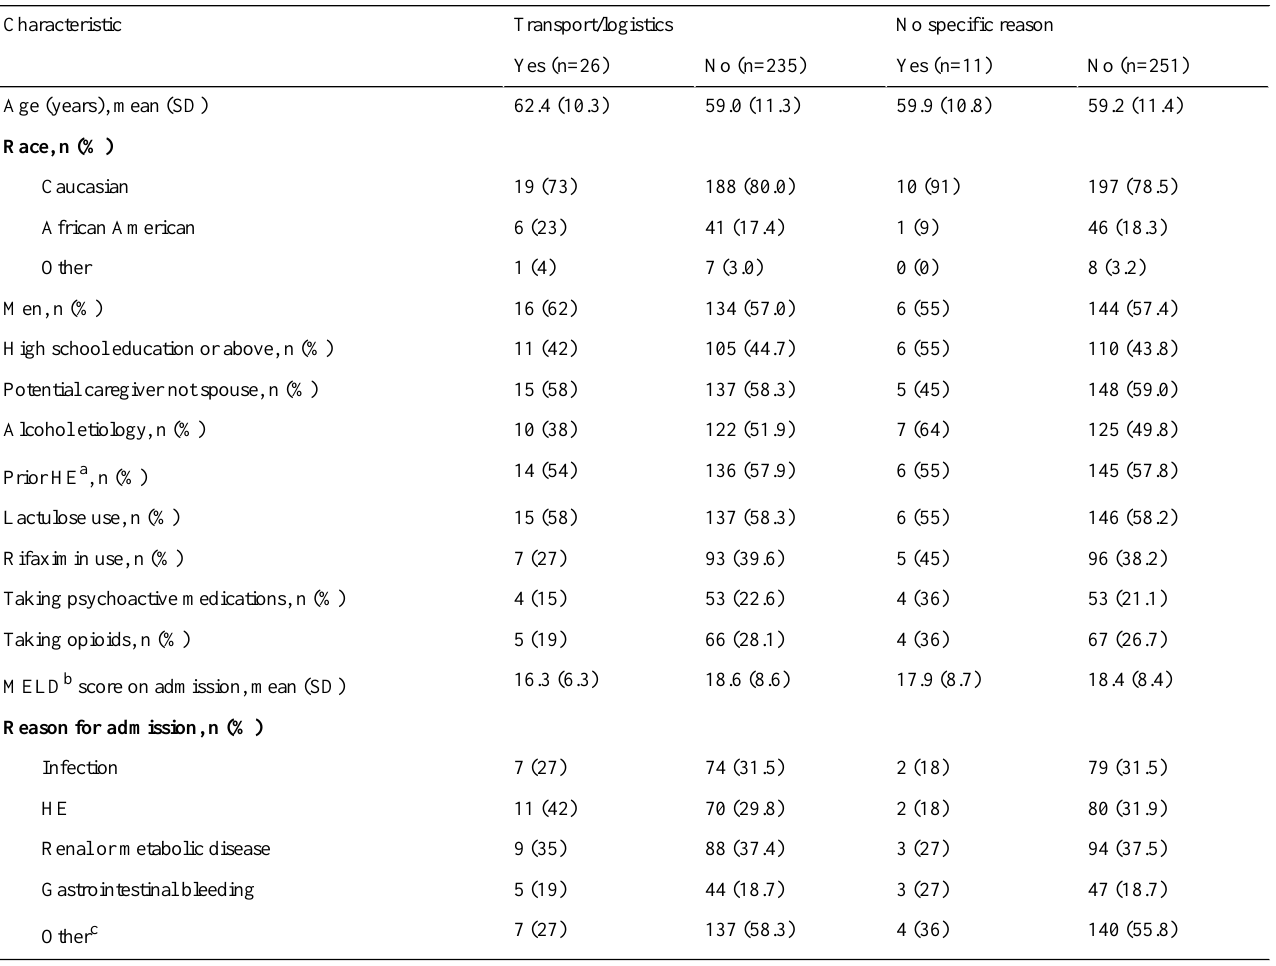
Table 3. Further reasons for refusal to participate in relation to patient characteristics (N=262).